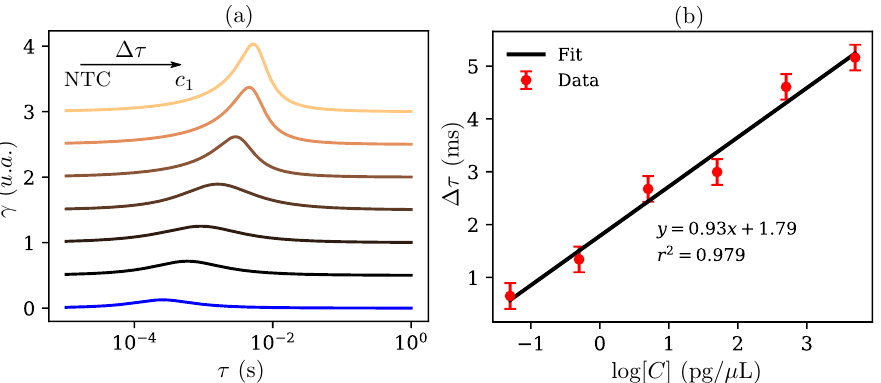
Figure 3. ( a ) Time-constant-domain spectroscopy filtered signals preserving only the charge transfer process. The spectra are normalized in amplitude for the negative template control (NTC) and six concentrations. ( b ) Calibration curve using TCDS as the transduction signal. Sensor response ∆ τ as a function of the logarithmic concentration of SARS-CoV-2